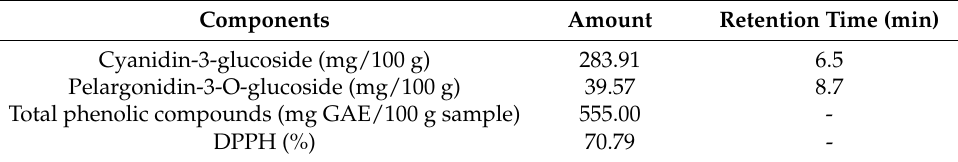
Table 2. Characterization of black corn anthocyanin-rich extract